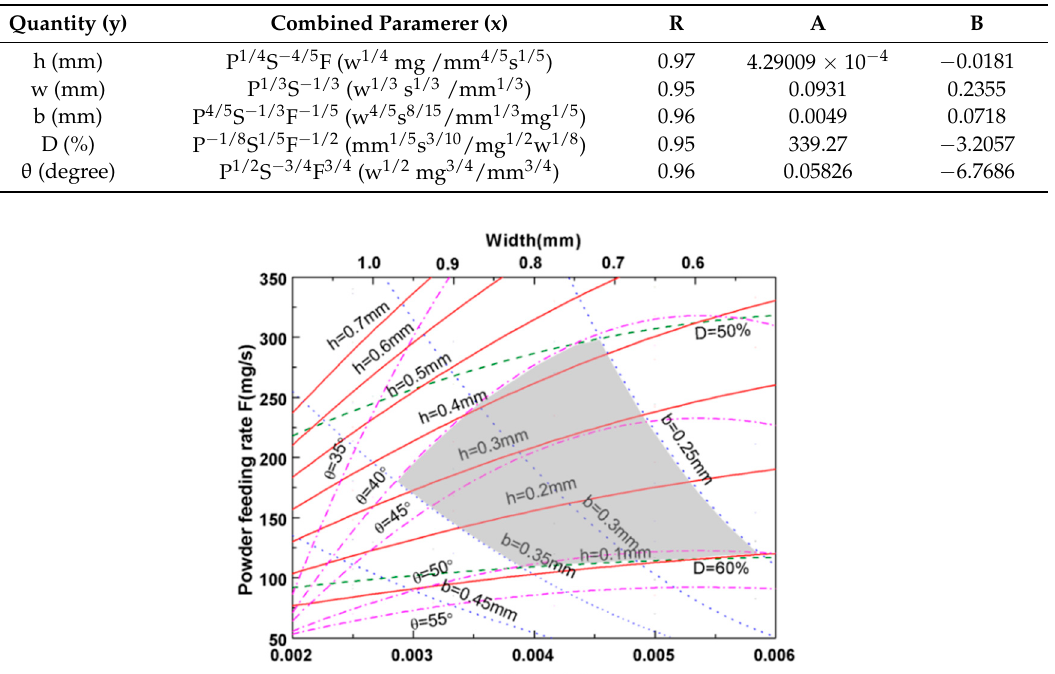
Figure 10. The laser cladding processing map of 85 wt.% Ti + 15 wt.% TiBCN powder on 7075 aluminum alloy substrate in F vs. S/P representation.